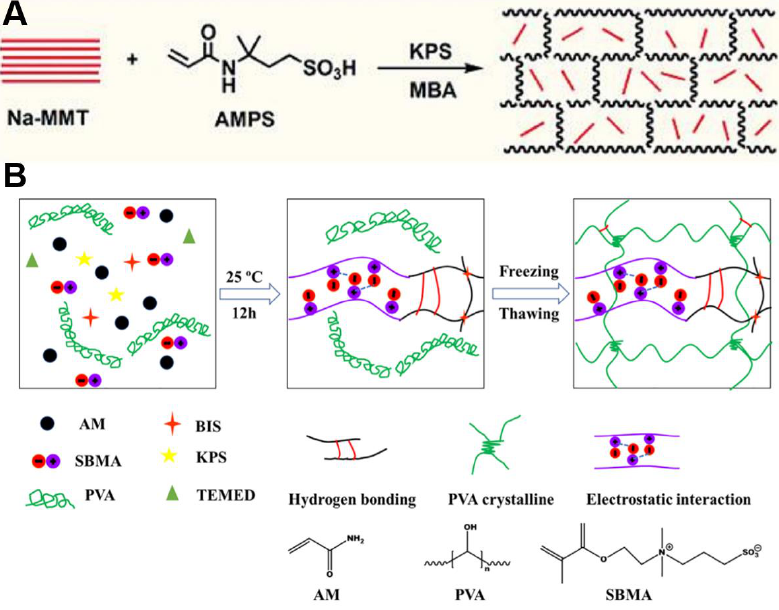
Figure 2. ( A ) Schematic presentation of the PAMPS/MMT composite hydrogel [38]. ( B ) Schematic of fabrication of PVA/P(AM-co-SBMA) hydrogel [40]. Copyright: Elsevier B.V. and John Wiley and